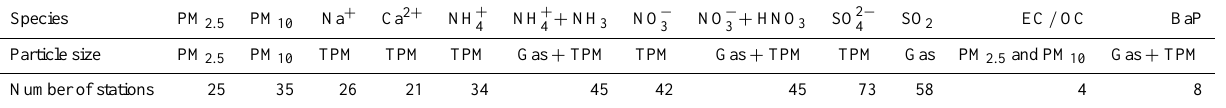
Table 3. The availability of concentration data for the relevant chemical species from the EMEP network in 2005. Species PM 2 . 5 PM 10 Na + Ca 2 + NH + 4 NH + 4 + NH 3 NO − 3 NO − 3 + HNO 3 SO 2 − 4 SO 2 EC / OC BaP Particle size PM 2 . 5 PM 10 TPM TPM TPM Gas + TPM TPM Gas + TPM TPM Gas PM 2 . 5 and PM 10 Gas + TPM Number of stations